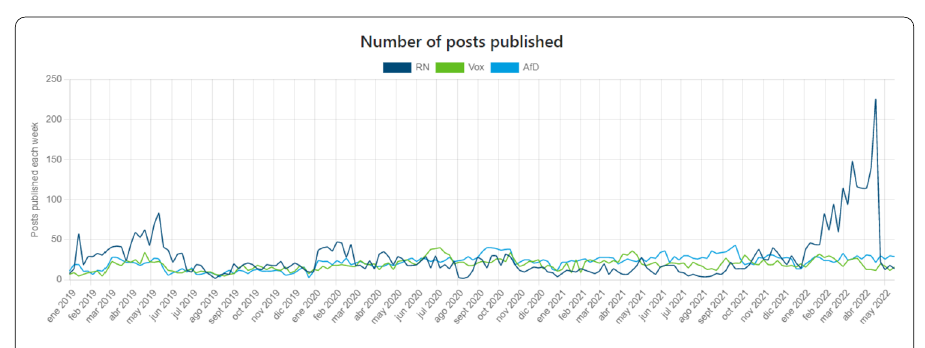
Figure 13 Post-activity of RN, Vox and